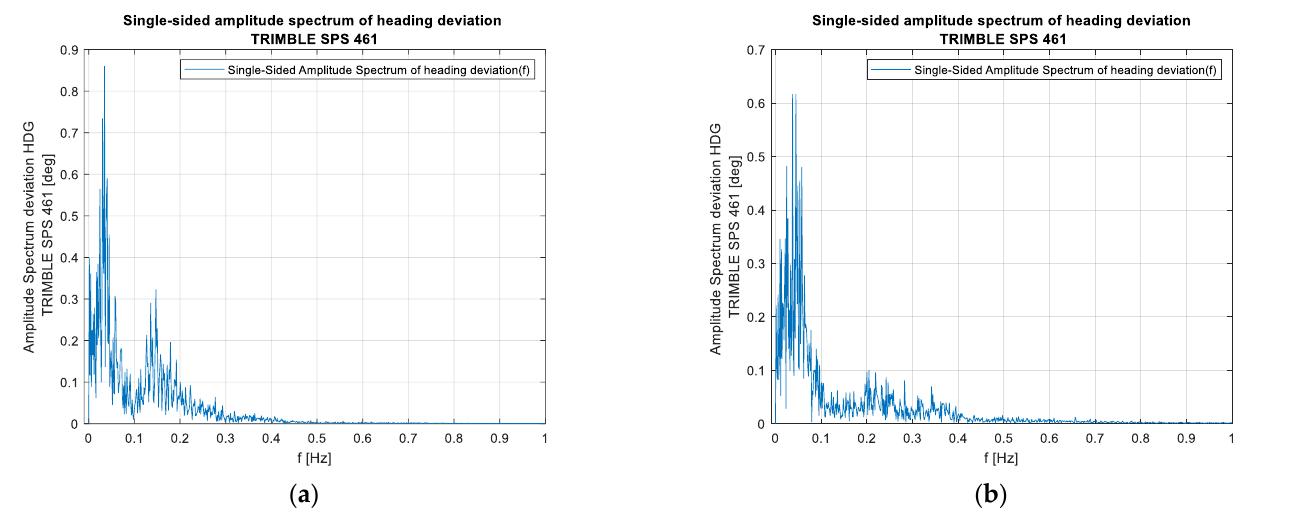
Figure 7. Typical recordings of the course made on the WildCat catamaran (time domain): ( a ) test #1, the vessel’s course is opposite to the wind direction, and ( b ) test #2, the vessel’s course follows the wind direction.